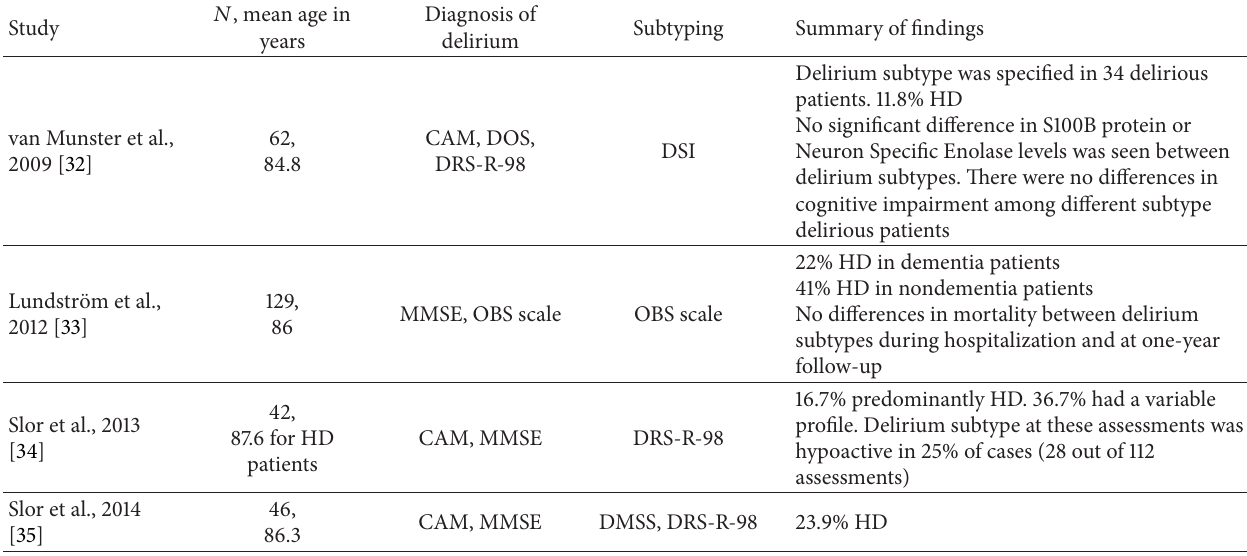
Table 3: HD in patients with hip